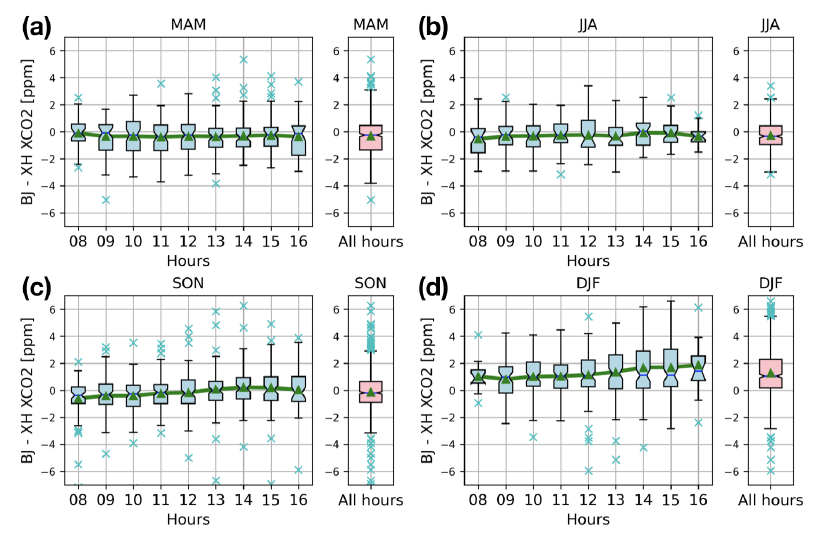
Figure 6. Box plots of the ∆ XCO 2 (BJ-XH) observed by two FTIR measurements in each hour and in four seasons (( a ) MAM: spring; ( b ) JJA: summer; ( c ) SON: autumn; ( d ) DJF: winter). Each box plot shows the values of relative difference for the maximum (upper solid line), 75th percentile (top of box), median (line through middle of box), mean (green triangle), 25th percentile (bottom of box), and minimum (bottom of solid line) of the distribution. The blue crosses are the outliers.